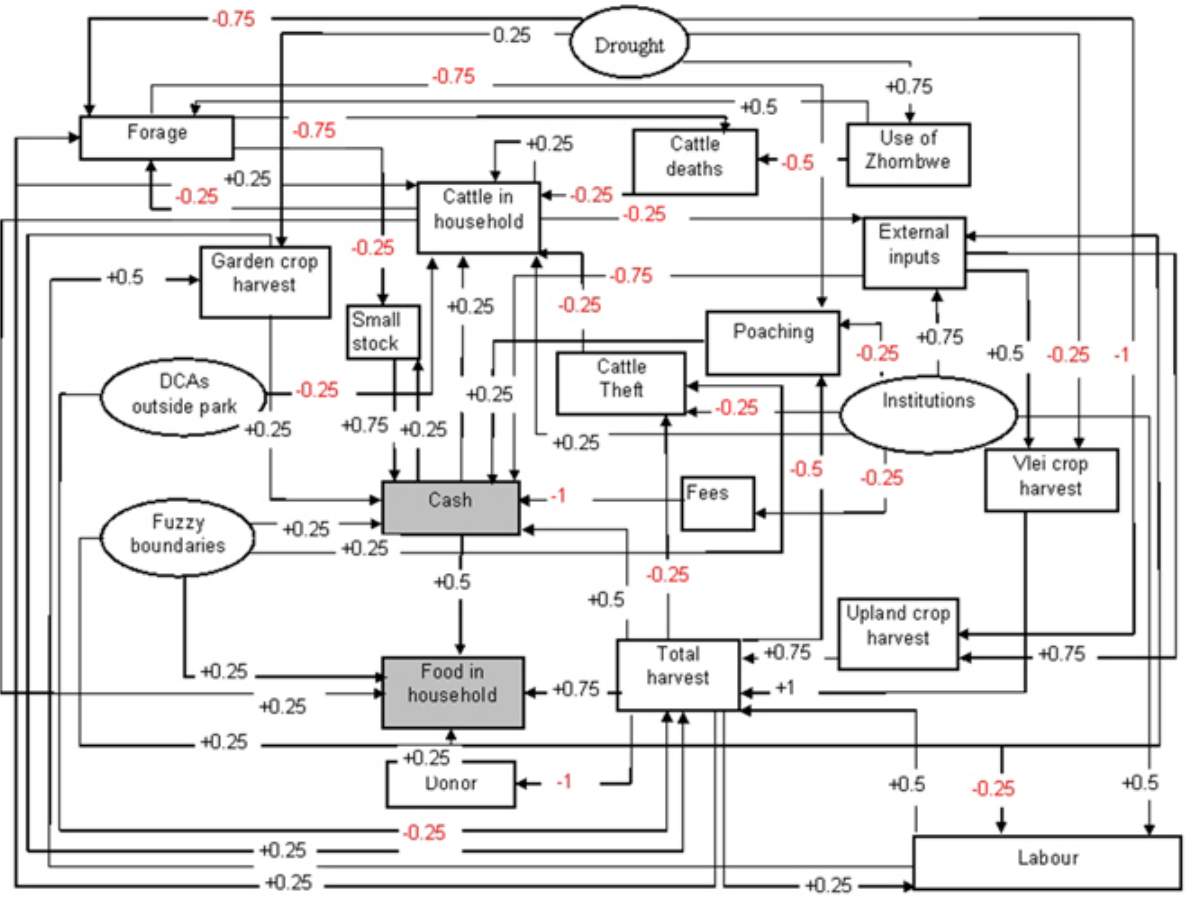
Fig. 5. Fuzzy cognitive map of the crop-cattle-based livelihood type. Grey boxes are key indicators of the functioning of the livelihood; white boxes are variables; white circles are system drivers. Numbers given are influences between factors, where red font indicates negative relationships, and black font indicates positive